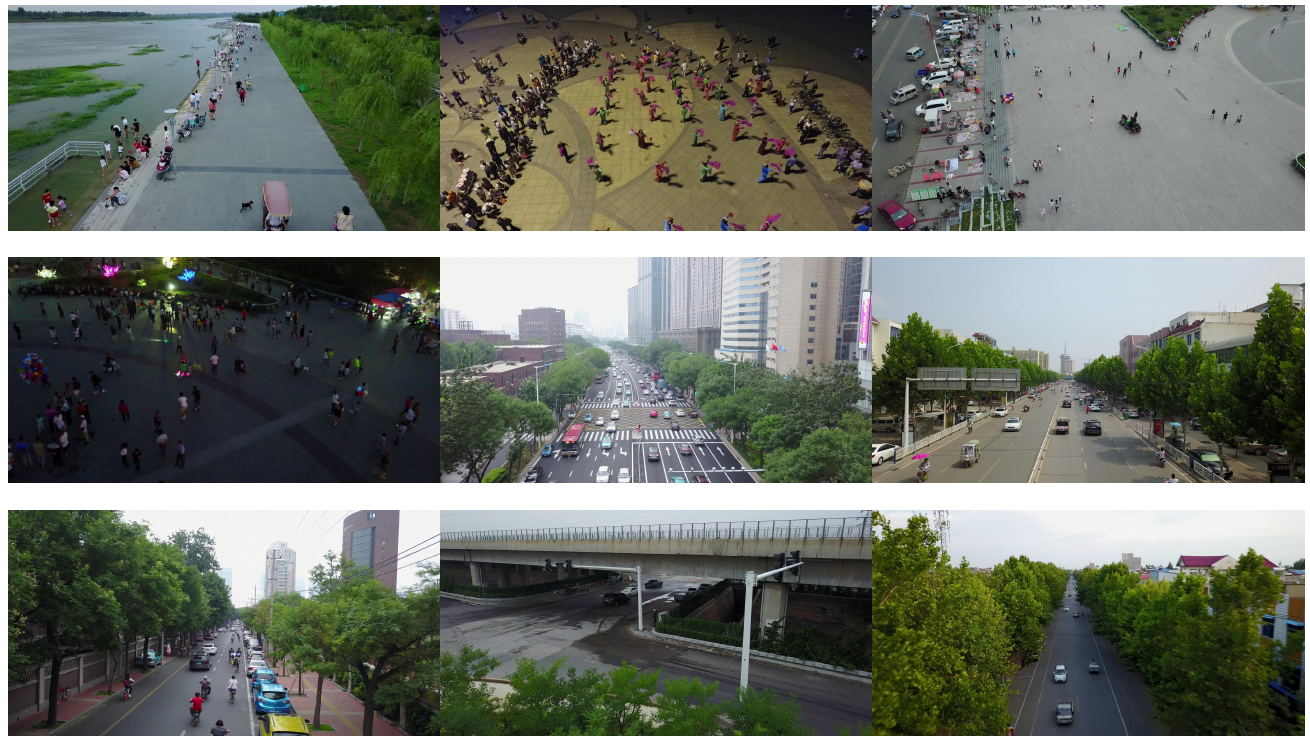
Figure 7. A few instances of the images in the VisDrone